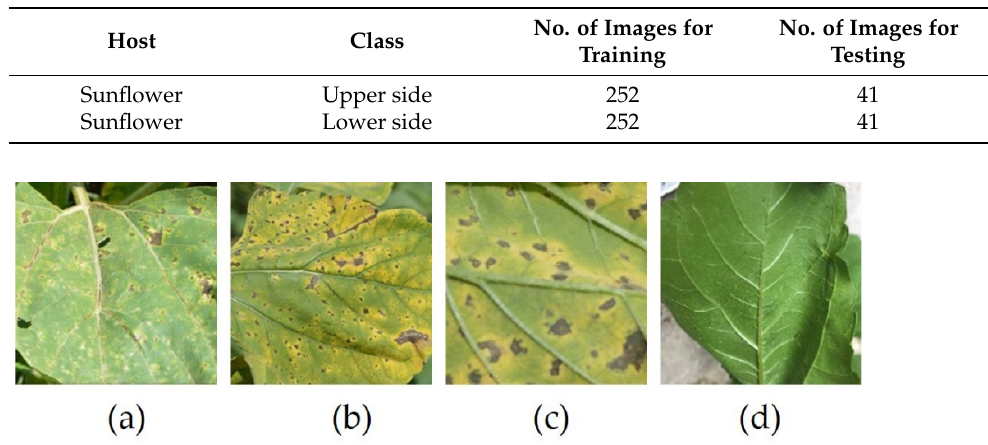
Table 2. Dataset used for classification.